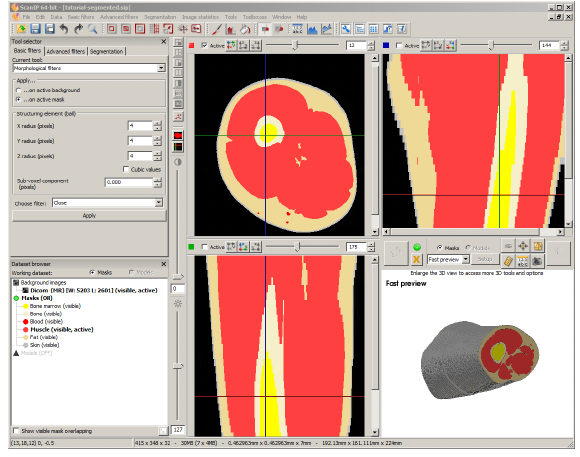
Fig. 2: A typical SIP window. In this particular case, after segmentation.